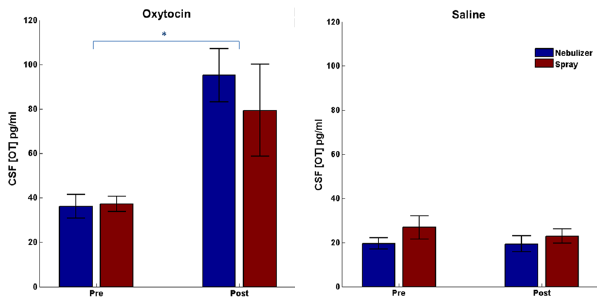
Figure 1. Cerebral spinal fluid (CSF) Oxytocin (OT) concentra- tion. Values shown are the mean 6 SEM (n=15). A. OT concentration in CSF before and 40 minutes after intranasal OT administration, * p , .05. B. OT concentration in CSF before and 40 minutes after intranasal